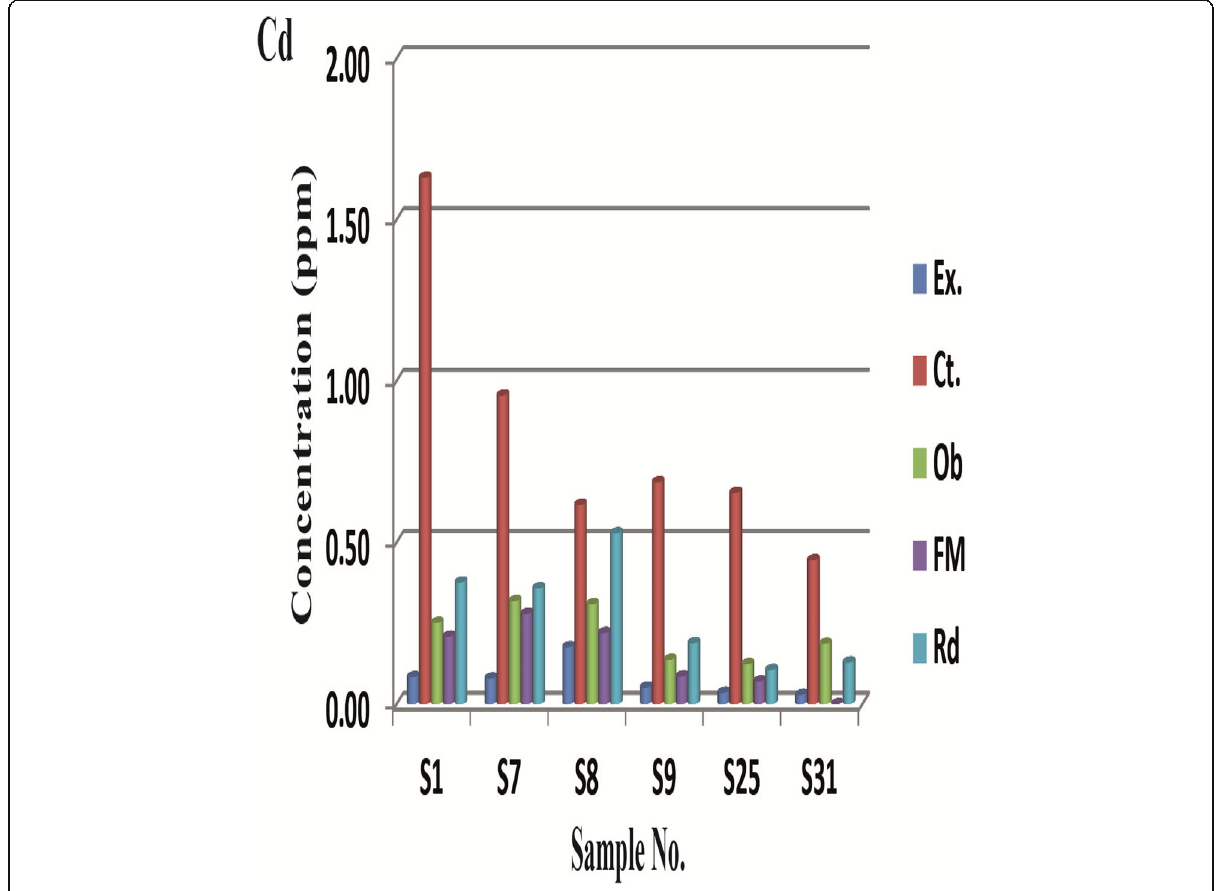
Fig. 3 Distribution of Cd among the various soil fractions in the study area